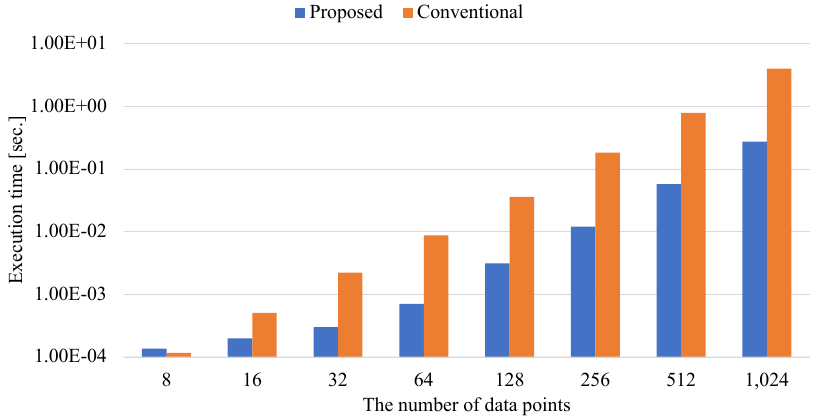
Figure 11. The execution time of determining the elements of the externally-constrained QUBO matrix.